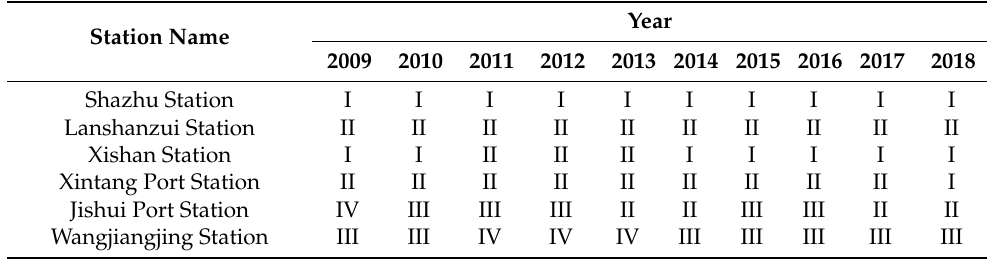
Table 4. Water quality evaluation results based on the T-S fuzzy neural network evaluation